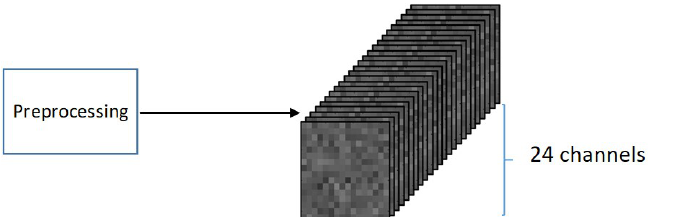
Figure 6. Example of one image in the dataset (24 channels) used as the CNN